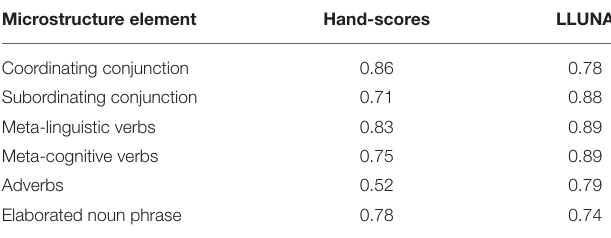
TABLE 2 | K qw for LLUNA and expert scores.